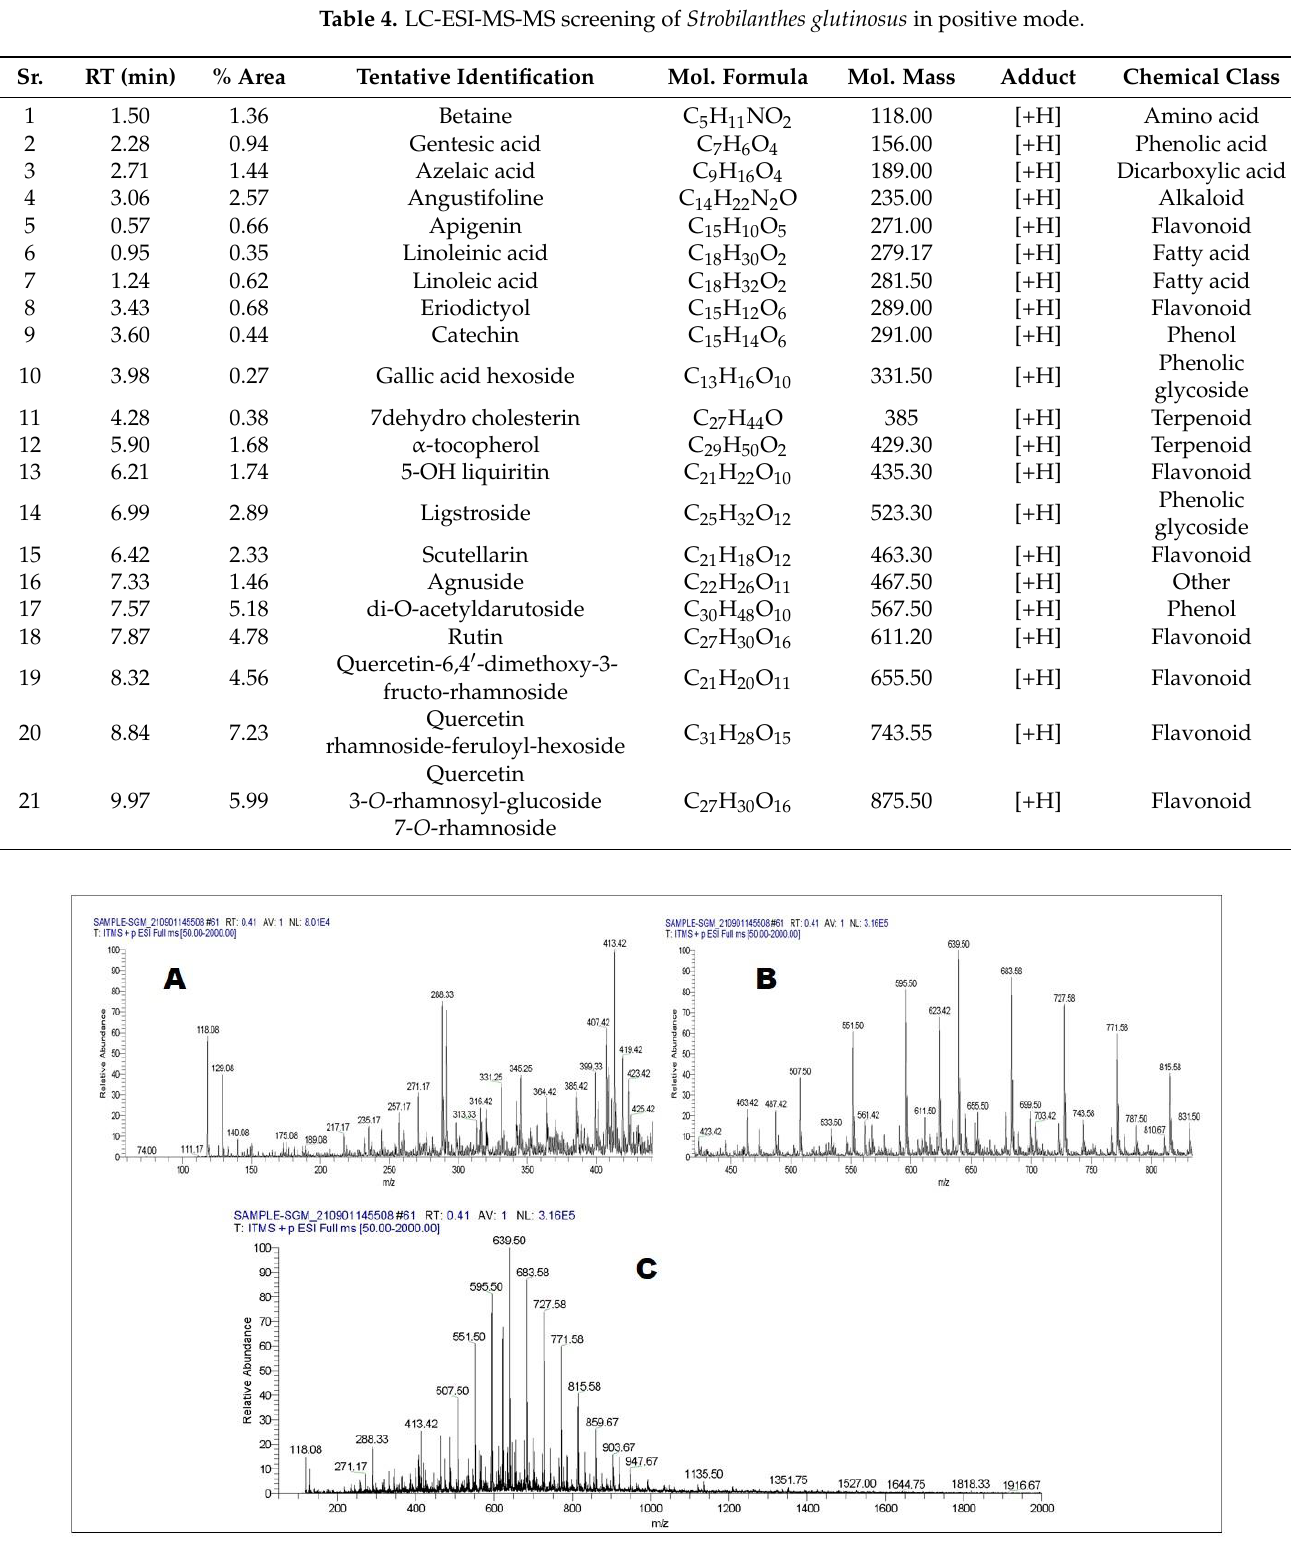
Table 5. Antioxidant results by different methods of S. glutinosus whole plant extract/fractions.